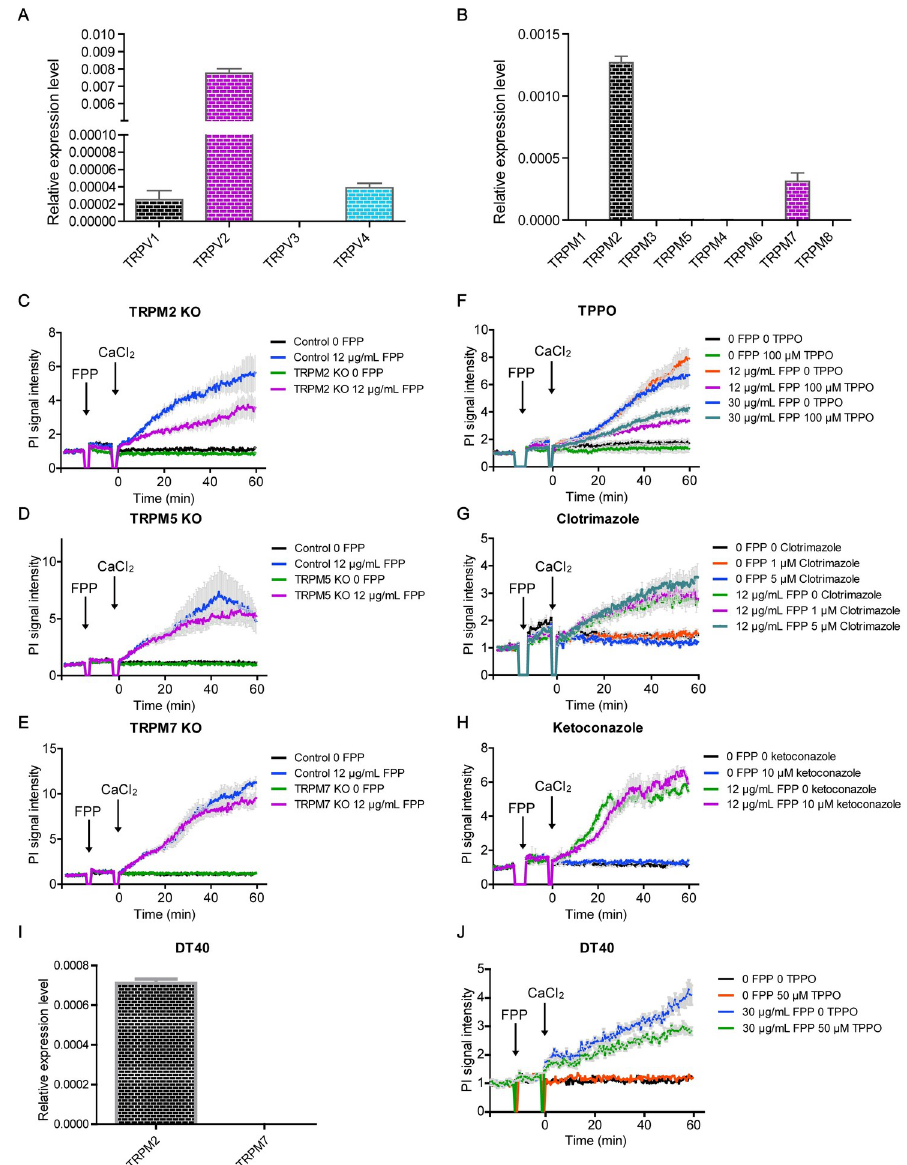
Fig 5. FPP-induced cell death is dependent on TRPM2 channel. (A) Relative mRNA level of TRPV1/2/3/4 in mast cell detected by qPCR. (B) Relative mRNA level of TRPM1/2/3/4/5/6/7/8 in mast cell detected by qPCR. (C–E) TRPM2 (C), TRPM5 (D), and TRPM7 (E) KO and their effect on FPP-induced cell death. Each treatment had 3 to 4 replicates. Bars denote mean ± SEM (SEM in gray). The first black arrow indicates the addition of FPP, and the second black arrow indicates the addition of CaCl 2 . Significant difference between control FPP and TRPM2 KO FPP group shows up from 40 minutes on ( p < 0.05). Two-way ANOVA analysis is used. (F–H) TRPM inhibitors TPPO (F), clotrimazole (G), and ketoconazole (H) were used to disturb FPP-induced cell death. Each treatment had 3 to 4 replicates. Bars denote mean ± SEM (SEM in gray). The first black arrow indicates the addition of FPP, and the second black arrow indicates the addition of CaCl 2 . Significant difference between 12 μ g/mL FPP 0 TPPO and 12 μ g/mL FPP 100 μ M TPPO group shows up from 30 minutes on ( p < 0.05). Significant difference between 30 μ g/mL FPP 0 TPPO and 30 μ g/mL FPP 100 μ M TPPO group shows up from 28.5 minutes on ( p < 0.05). Fig 5 A–H is done with P815 cells. (I) TRPM2 and TRPM7 expression level in DT40 cells were checked with qPCR. (J) TPPO inhibit FPP-induced DT40 cell death. DT40 cells were preincubated with 50 μ M TPPO for 45 minutes and then treated with 30 μ g/mL FPP and CaCl 2 . PI signal increase under fluorescent microplate reader. Black arrows indicate the time points at which different metabolites were added. Each treatment had 3 to 4 replicates. Bars denote mean ± SEM (SEM in gray). Significant difference in 50 μ M TPPO FPP group compared to the 0 TPPO FPP group shows up from 30 minutes on ( p <